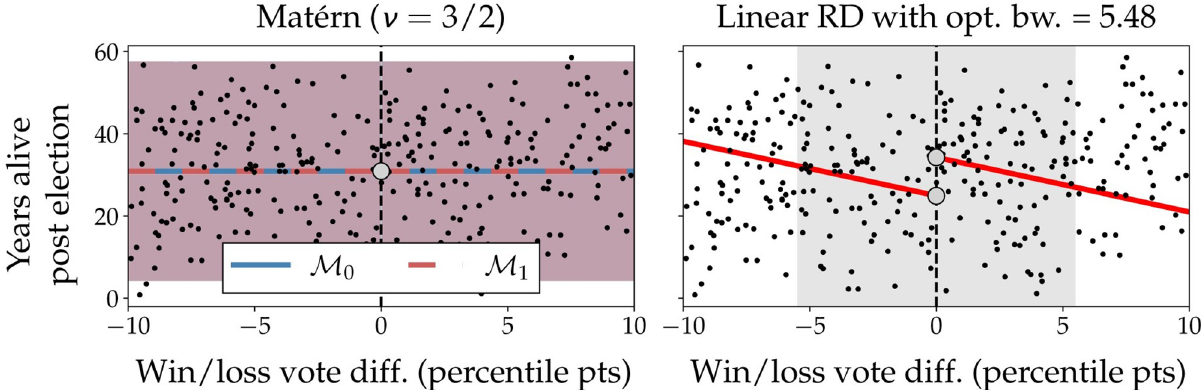
Fig 4. Election result effects on longevity. Discontinuity analysis of the effect of close gubernatorial elections on longevity [44]. Shown are regressions by BNDD using a Mate´rn covariance function, and a linear RD baseline with an optimized bandwidth of 5.48 percentile points (shaded area). For BNDD, the regressions for M and M are nearly identical. For the baseline, the bandwidth optimization leads to a poor linear fit, and hence a 0 1 spurious detection of an effect.